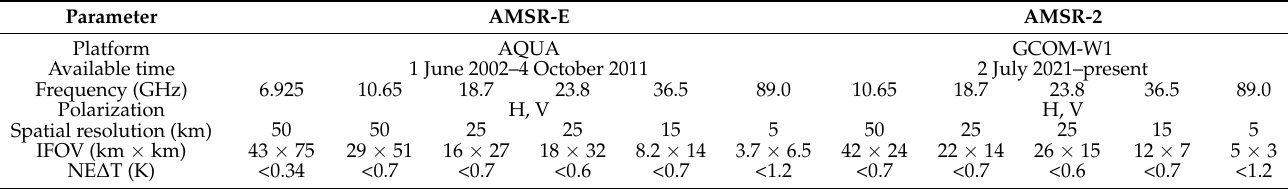
Table 1. Major performances of the AMSR-E and AMSR-2